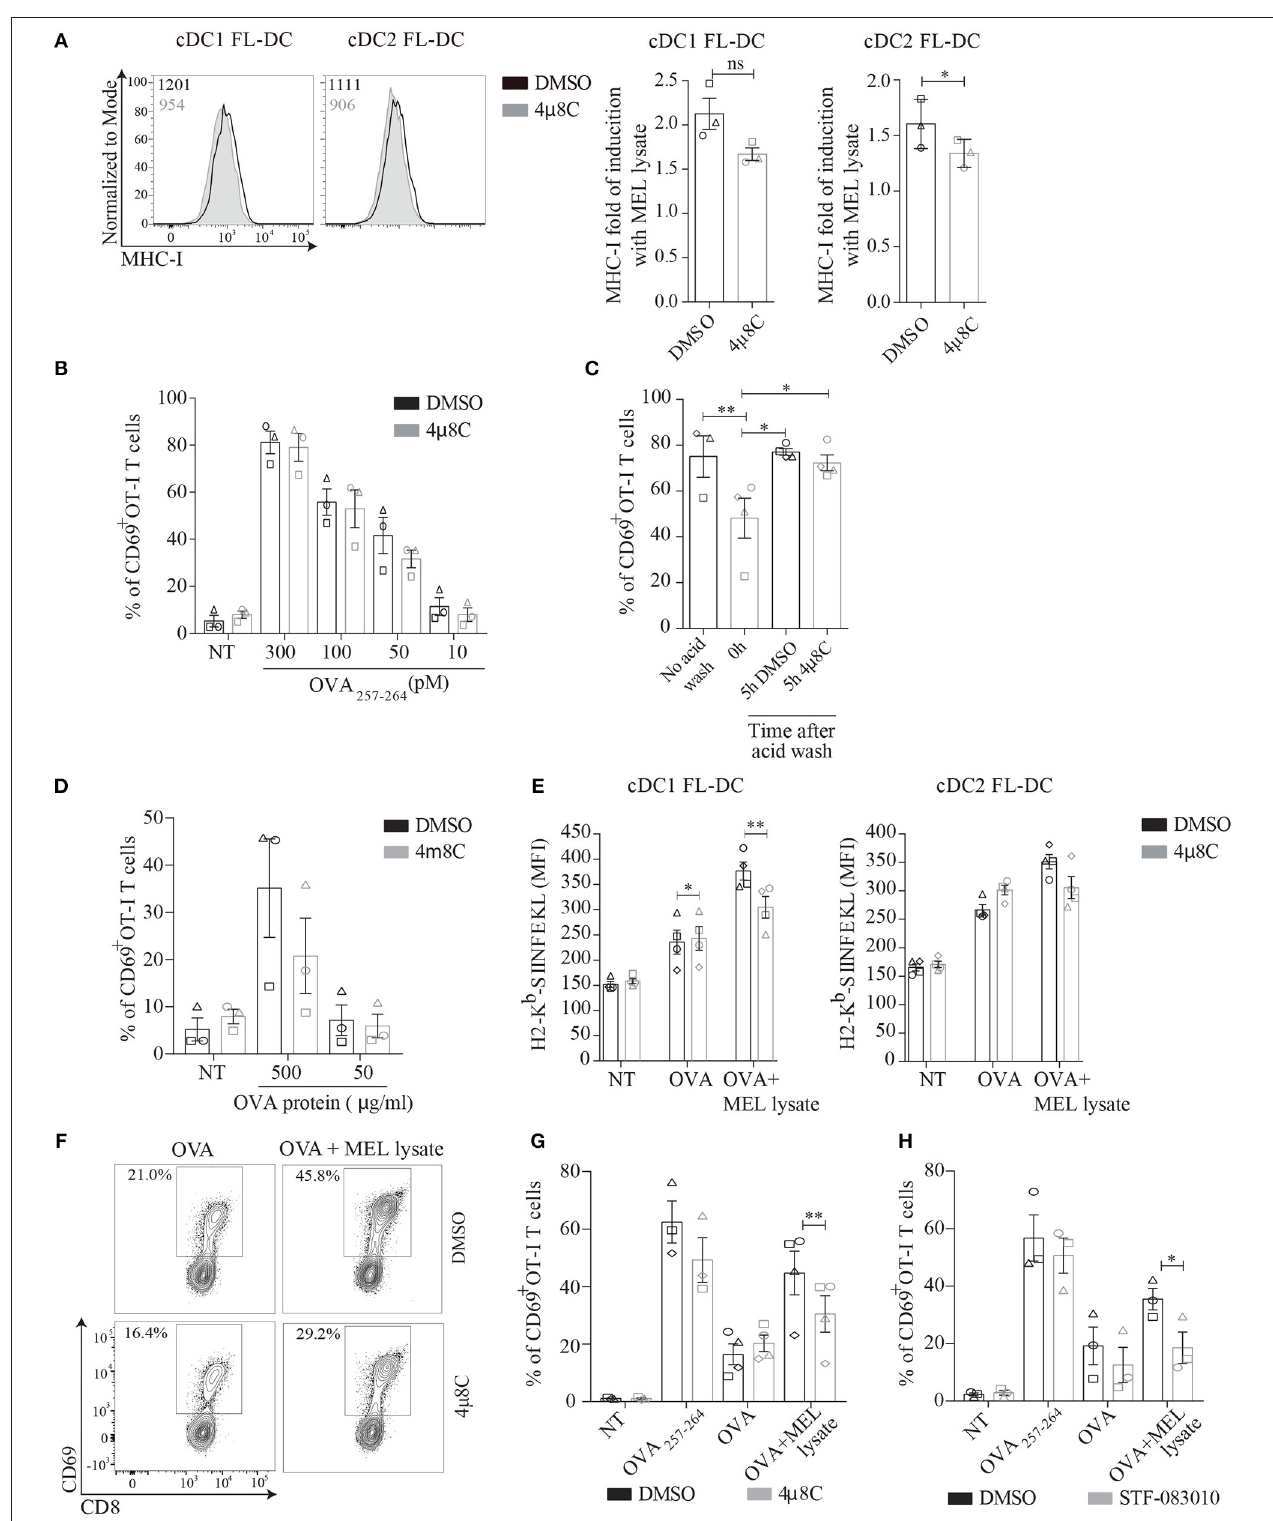
FIGURE 4 | MEL adjuvant function in MHC-I cross-presentation is reduced by inhibition of IRE1 α signaling in BMDCs. (A) FL-DCs were incubated with 50 µ M 4 µ 8C or DMSO for 6h and MHC-I expression was measured of cDC1 FL-DC (XCR1 + ) and cDC2 FL-DC (SIPR α + ) by flow cytometry. Data in graph depicts of three independent experiments. (B) FL-DCs were incubated with 50 µ M 4 µ 8C or DMSO for 6h and then were pulsed with increasing doses of SIINFEKL peptide for the